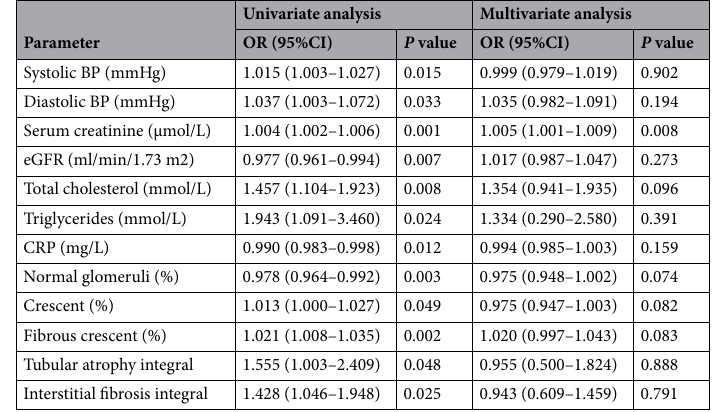
Table 3. Logistic regression analysis of factors related to a clinical diagnosis of ANCA-related renal vasculitis patients with